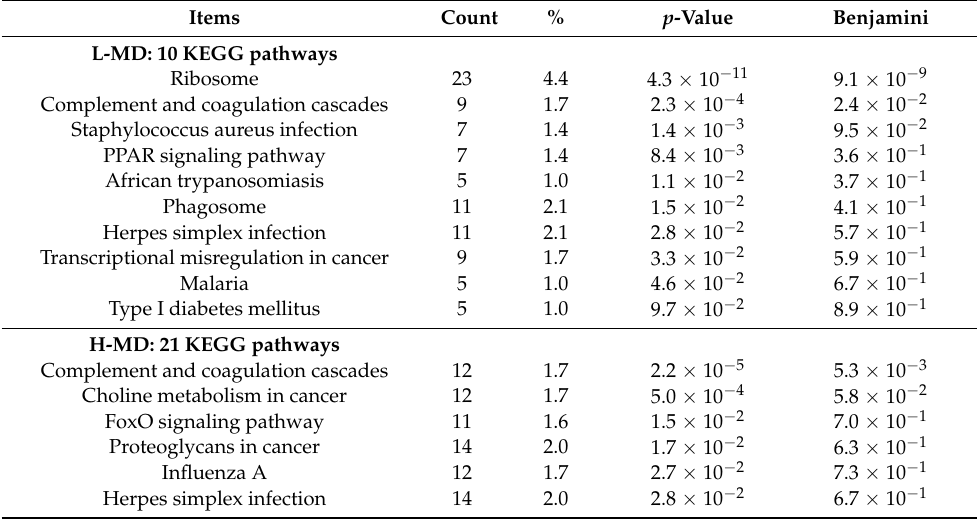
hypertension [30,31]. Table 3. Significantly regulated KEGG pathways in 12-week-old offspring’s kidney exposed to a methyl-deficient diet (L-MD), high methyl-donor diet (H-MD), and high methyl-donor diet plus melatonin treatment (H-MD+M).